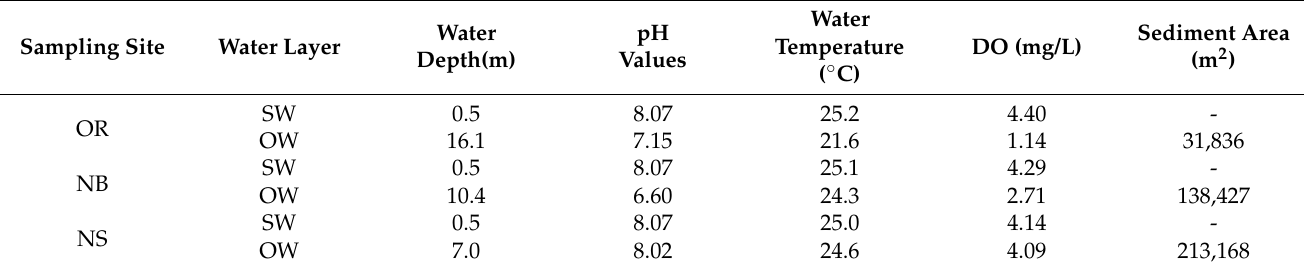
Table 2. In situ information of the sampling sites in LLJ.